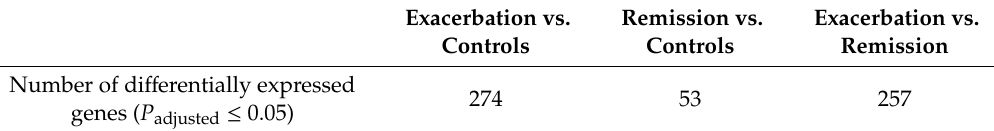
Table 7. Number of statistically significantly di ff erentially expressed genes in all three combinations of the three cohorts studied.